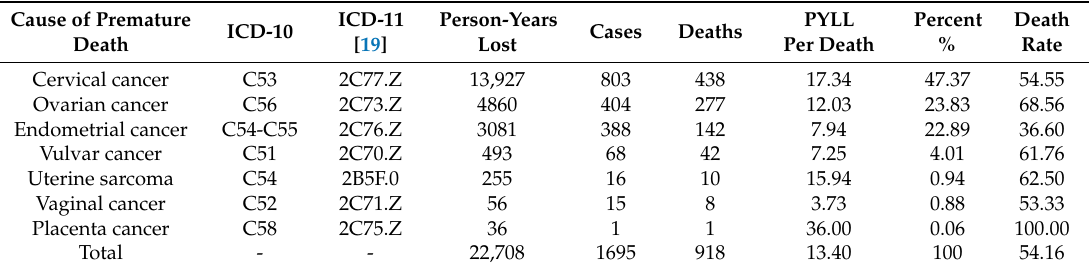
Table 4. PYLL in women aged 20–85 and over by cancer type, Arad,